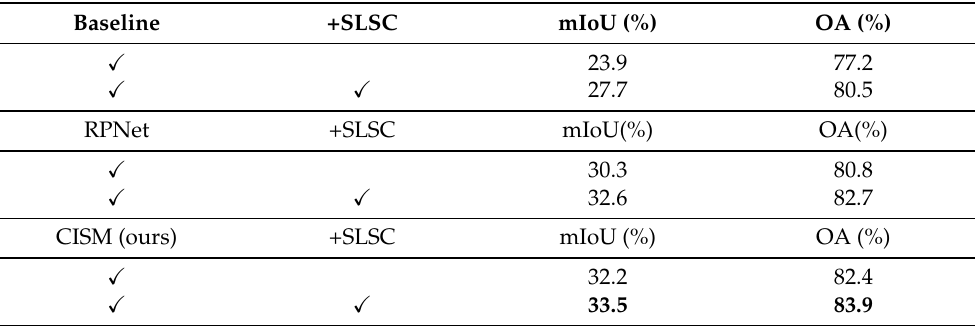
Table 6. Ablation researchof the effectiveness of the MCSG strategy. +SLSC means the addition of the Single-Label Secondary Classification. The effect of single-label secondary classification on the CAM quality using the mIoU (%) and OA (%) as the evaluation